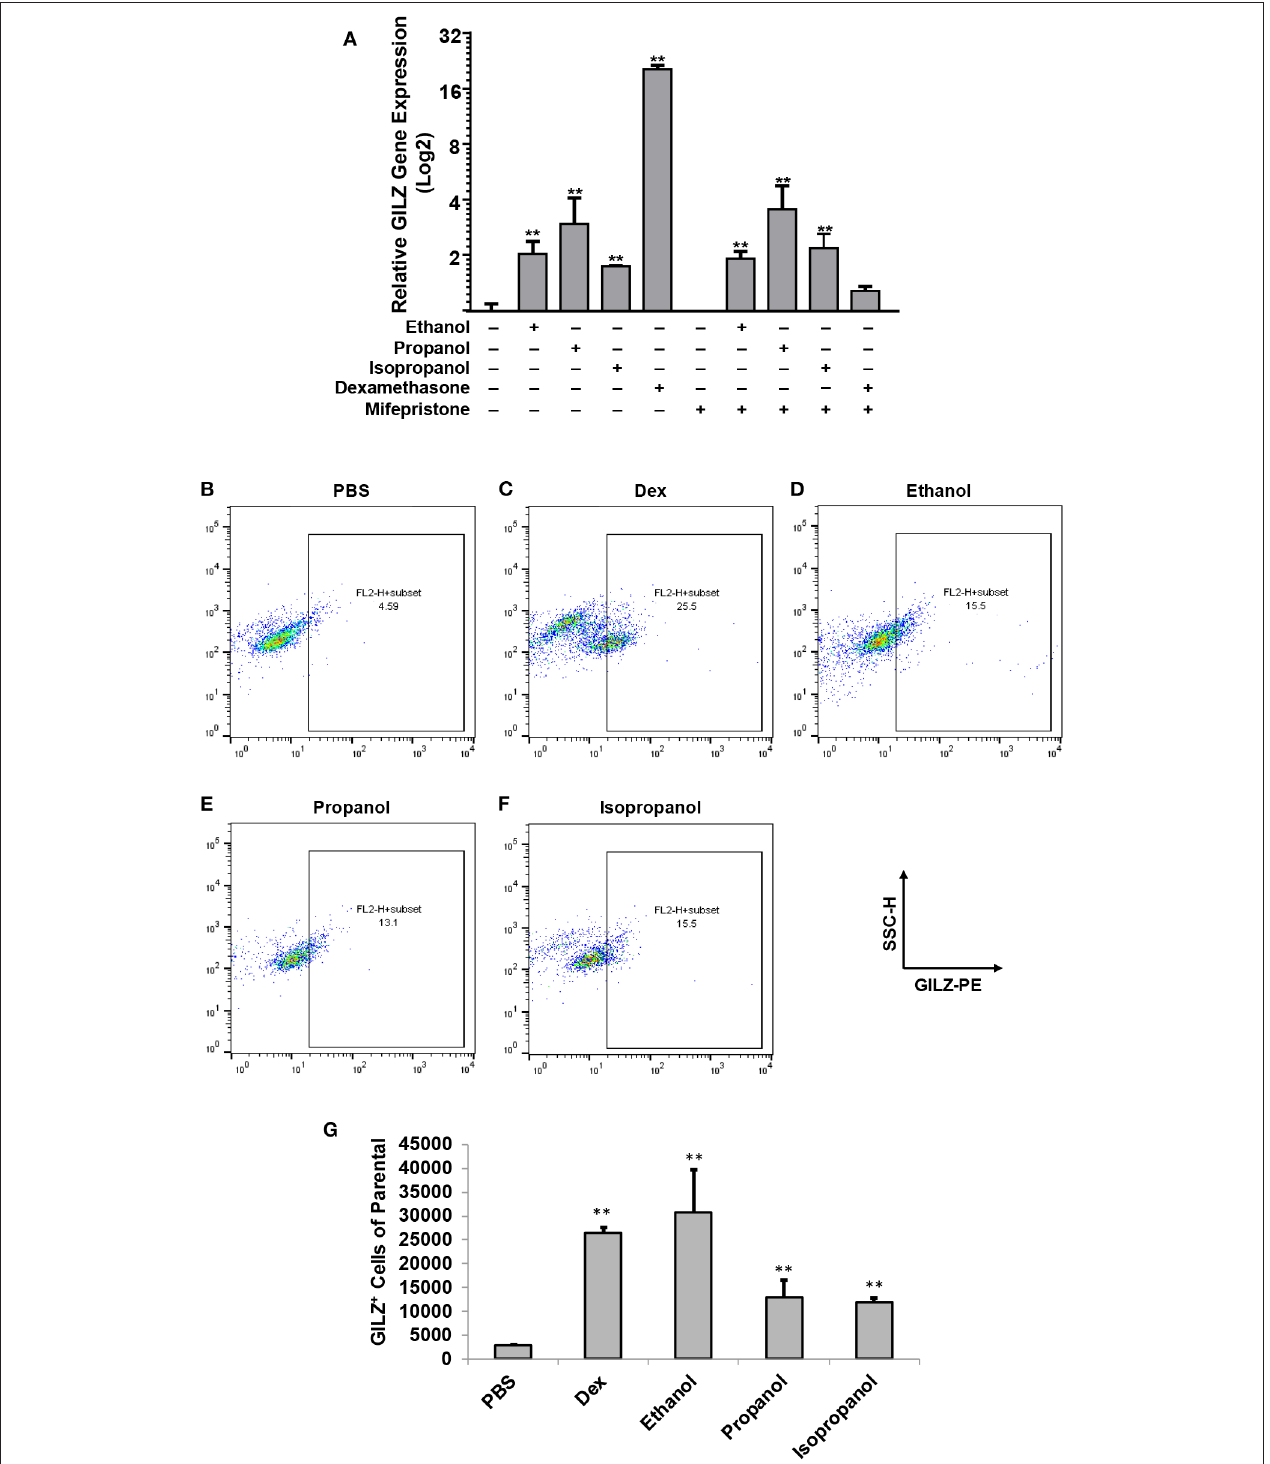
FIGURE 1 | Short-chain alcohols upregulate GILZ expression in vitro . (A) RT-qPCR to measure GILZ transcription. MM6 cells were exposed to ethanol, propanol, or isopropanol at 50mM for 24h. A PBS-control group of MM6 cells was similarly set. GILZ mRNA levels were determined by RT-qPCR. (B–F) Flow cytometry. The alcohol-exposed MM6 cells were immunostained for GILZ protein and analyzed by flow cytometry. Representative dot-plot data from each condition are shown. X-axis measures GILZ-PE staining, and Y-axis indicates sidescatter property. (G) Statistical data. Total 50,000 cells were acquired for each condition. GILZ-positive cells of the parental were expressed. Asterisks denote significant difference as compared to the respective control by Student’s t -test ( P < 0.01, n = 3 per condition).